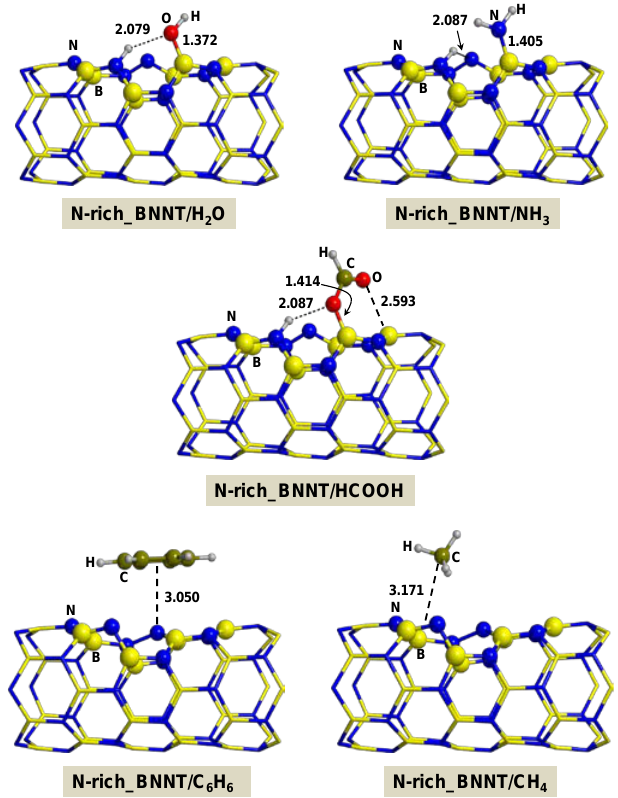
Figure 4. B3LYP-D2* optimized structures of the probe molecules interacting with N-rich_BNNT. Bond distances are in Å. The distances for N-rich_BNNT/C 6 H 6 are those between the centroid of the aromatic ring and the plane defined by the closest nonagon ring; for CH 4 , they are between the C atom and the plane defined by the closest nonagon ring.